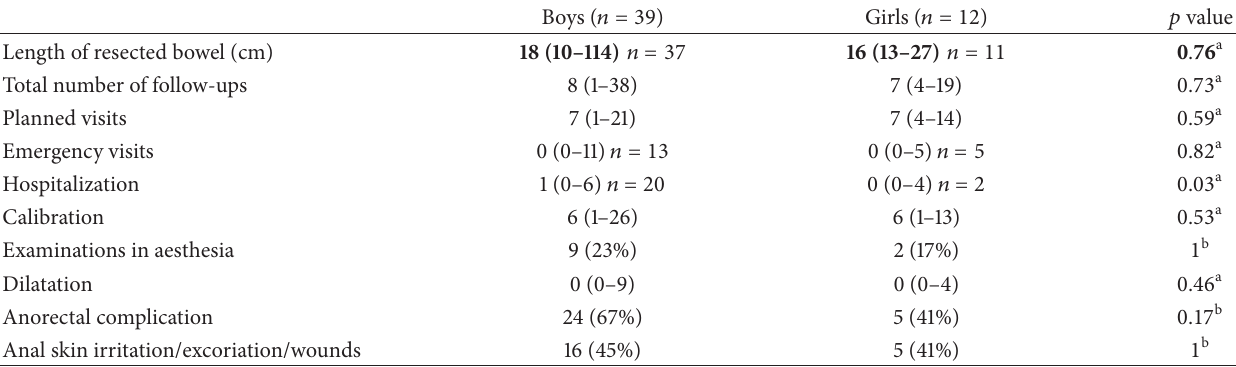
Table 4: First-year postoperative and operative data, median (range), 𝑛 : number. A total of 13 boys and 5 girls were admitted for emergency visits and a total of 20 boys and 2 girls were readmitted during the first year post-TERPT. The median value and the range are presented for the whole cohort, that is, both those who had emergency visits/or who were readmitted and those who were not. Boys ( 𝑛 = 39